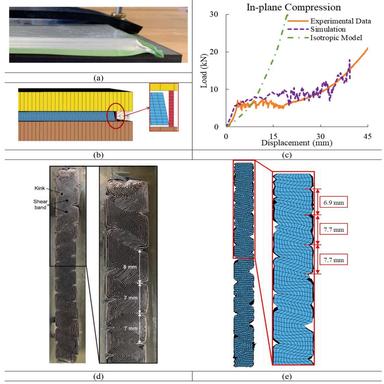
Confined in-plane compression (a) Side view of the pouch cell. The casing of the pouch cell makes the edges of the pouch cell a trapezoid rather than a perfect rectangular shape. (b) Details of the finite element model of in-plane compression simulation. The trapezoid battery model is confined between two thick shell plates which are connected by nine spring elements at each corner to replicate the same behavior as the screws in the experimental apparatus. (c) Comparison of experimental data and simulation.